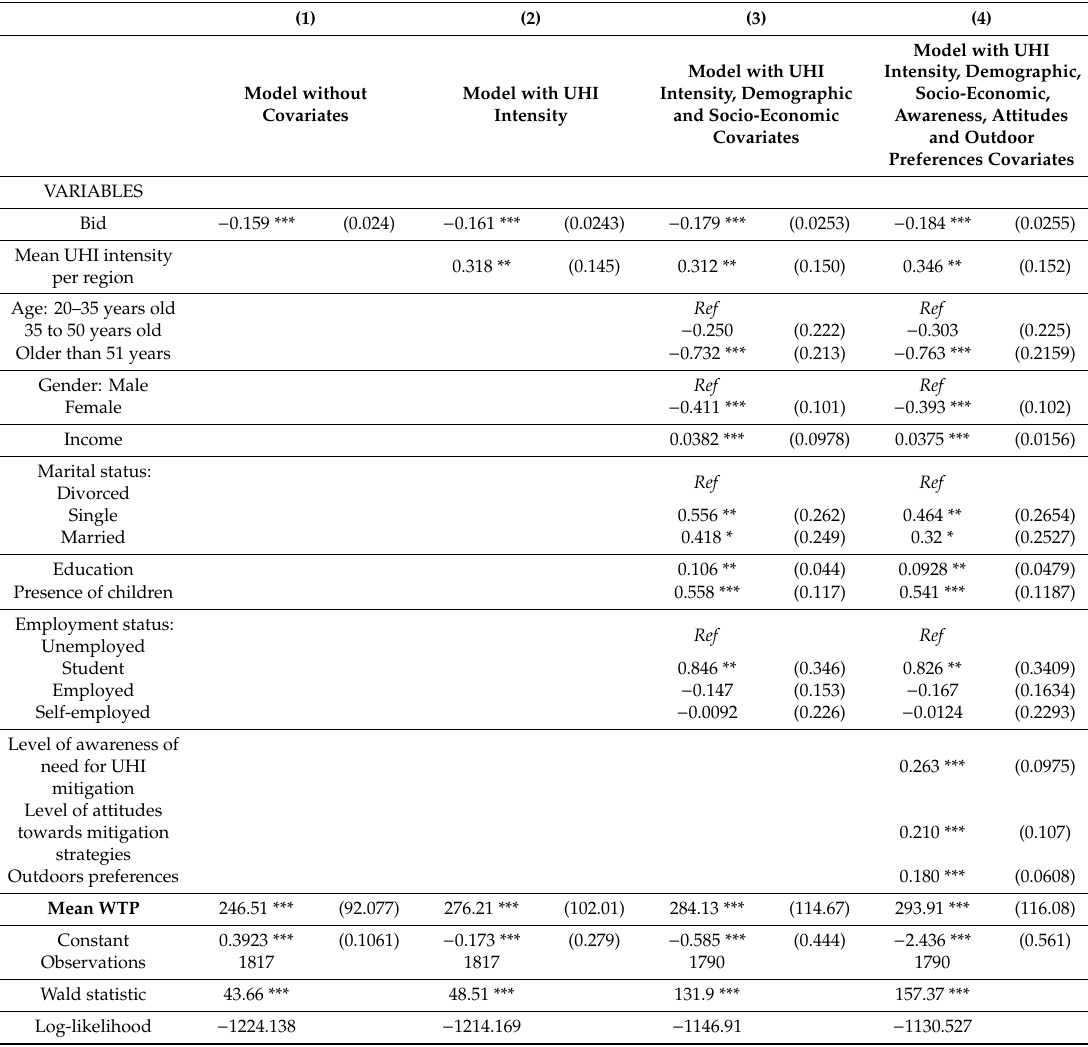
Table 6. Estimation results of the log- likelihood of a “YES” response to the